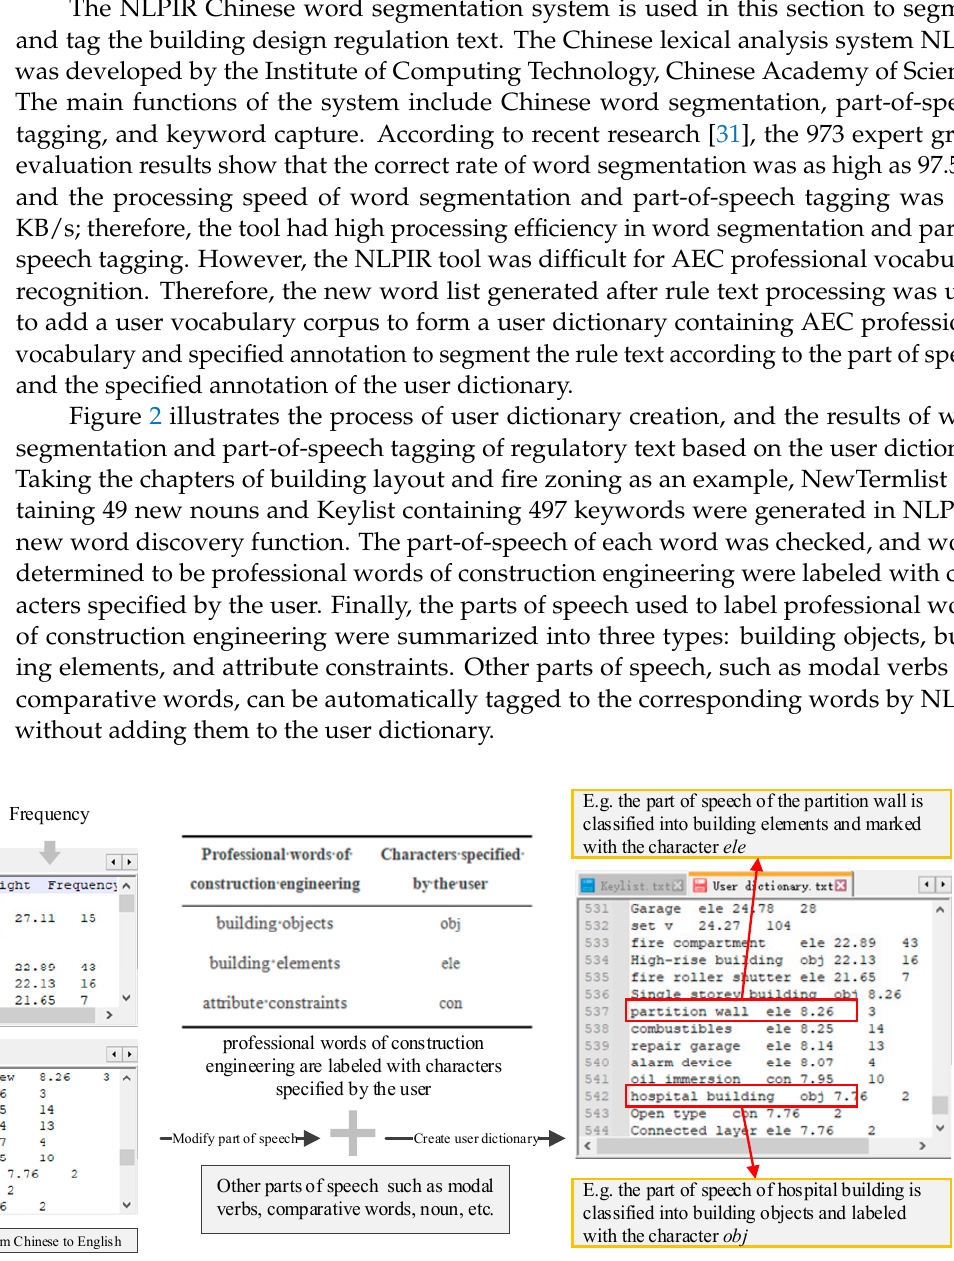
Figure 2. User dictionary creation based on NewTermlist and Keylist.